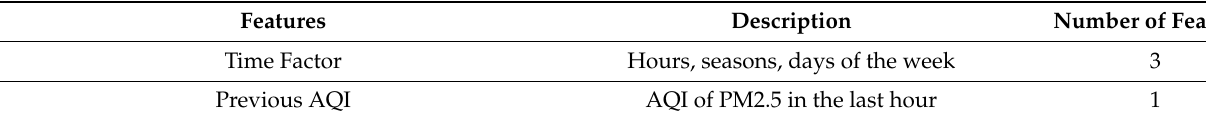
Table 1. Spatial and temporal characteristics related to air